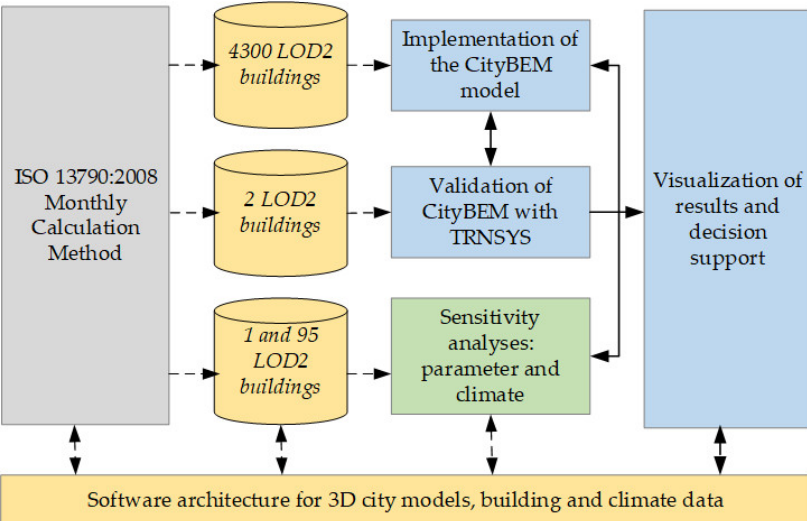
Figure 1. Overall research methodology of this study.